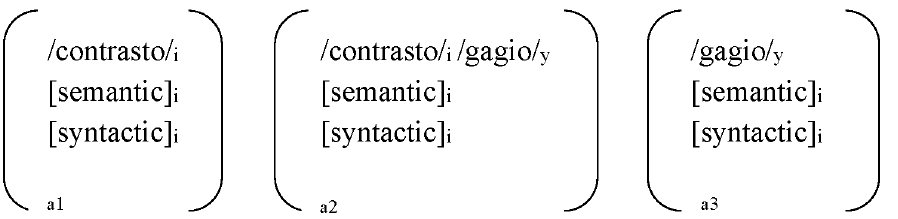
Figure 1. Neodritto relabelling model based on Lefebvre (2008).